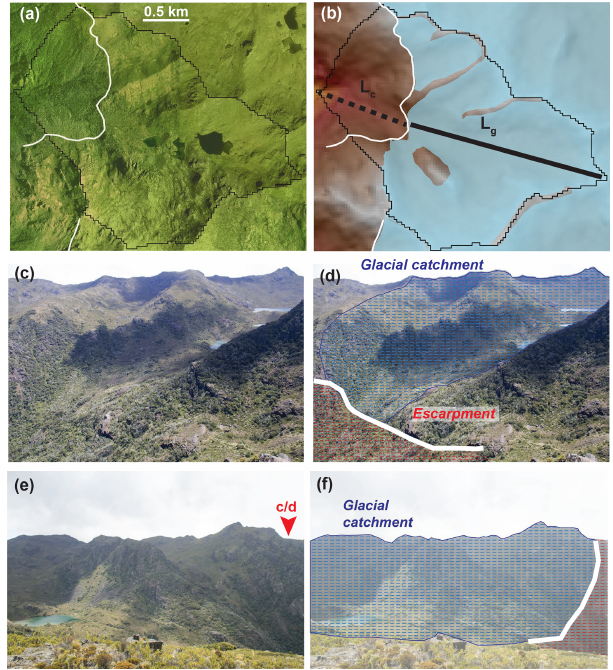
Figure 6. Scarp encroachment ratio (SER) calculation. (a) Aerial image of Valle de los Lagos, Chirripó, Costa Rica. Mapped escarp- ment in white. Boundary of catchment draining to 3000m outlet in black. (b) Mapped LGM ice extent in light blue draped over DEM of Valle de los Lagos (same bounds as in panel a ). Length scales Lc and Lg correspond to area below and above escarpment, respec- tively. SER calculation is presented in Eq. (2). (c–f) Field photos of mapped escarpment. Blue and red zones in panels (d) and (f) corre- spond to glaciated zone and escarpment. White line is the same as in panels (a) – (b) . (e) Vantage point for panels (c) and (d) labeled with red